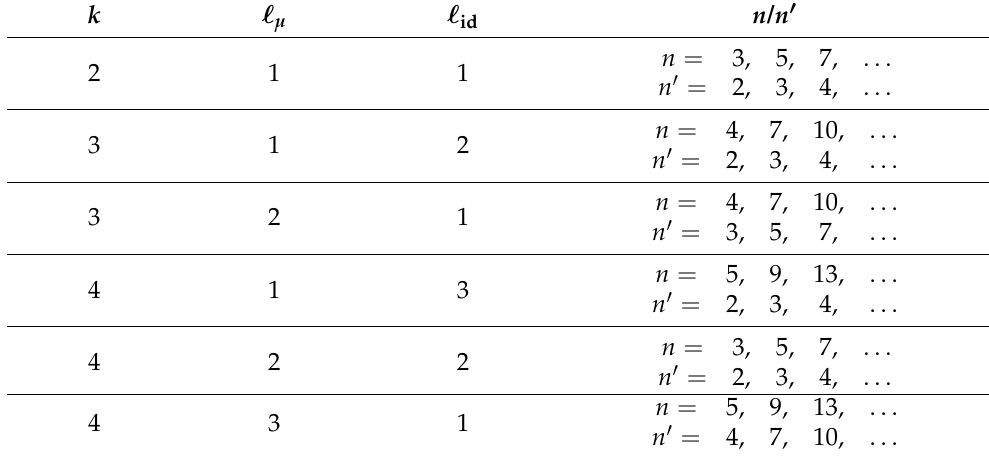
Table 1. Hetero power